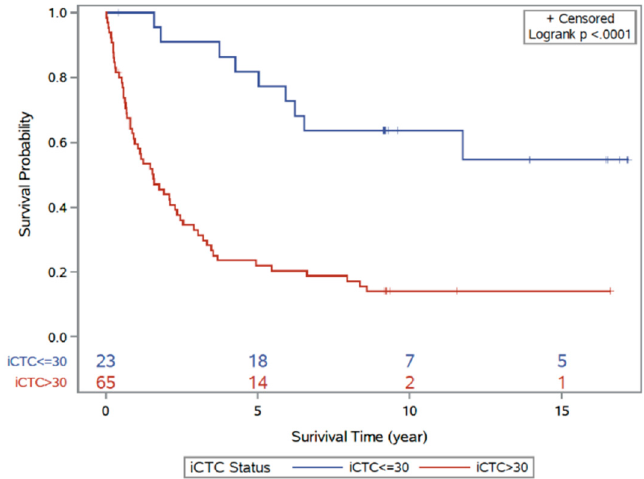
Figure 4. Kaplan–Meier curve analysis for disease outcome according to high-iCTC-count groups and low-iCTC-count groups using optimal iCTC cutoff point ( ≤ 30 iCTCs/mL vs. >30 iCTCs/mL). The two survival curves are significantly different (log-rank p -value < 0.001). The red line indicates the high iCTC count group; blue line indicates the low iCTC count group.